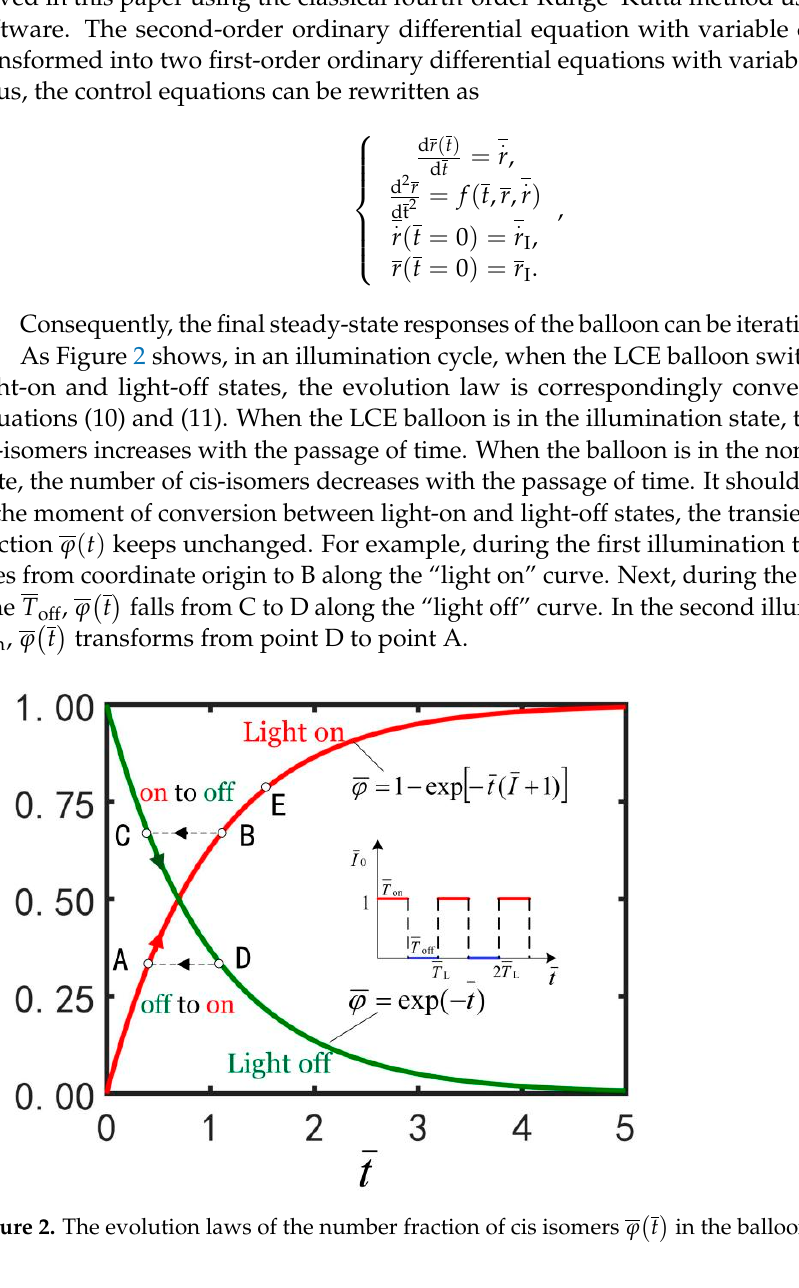
Figure 2. The evolution laws of the number fraction of cis isomers ϕ t .